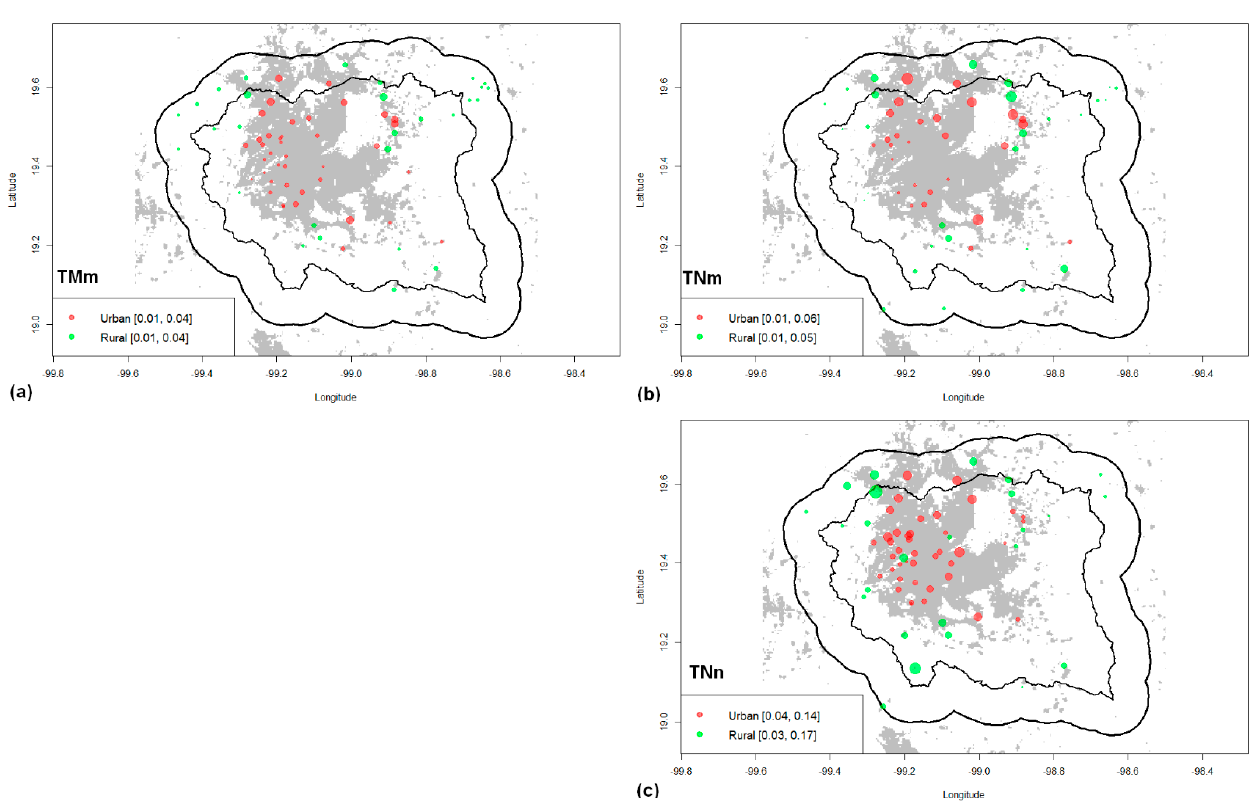
Figure 6. The same as in Figure 5 but for: ( a ) TMm (°C/year), ( b ) TNm (°C/year), and ( c ) TNn (°C/year).